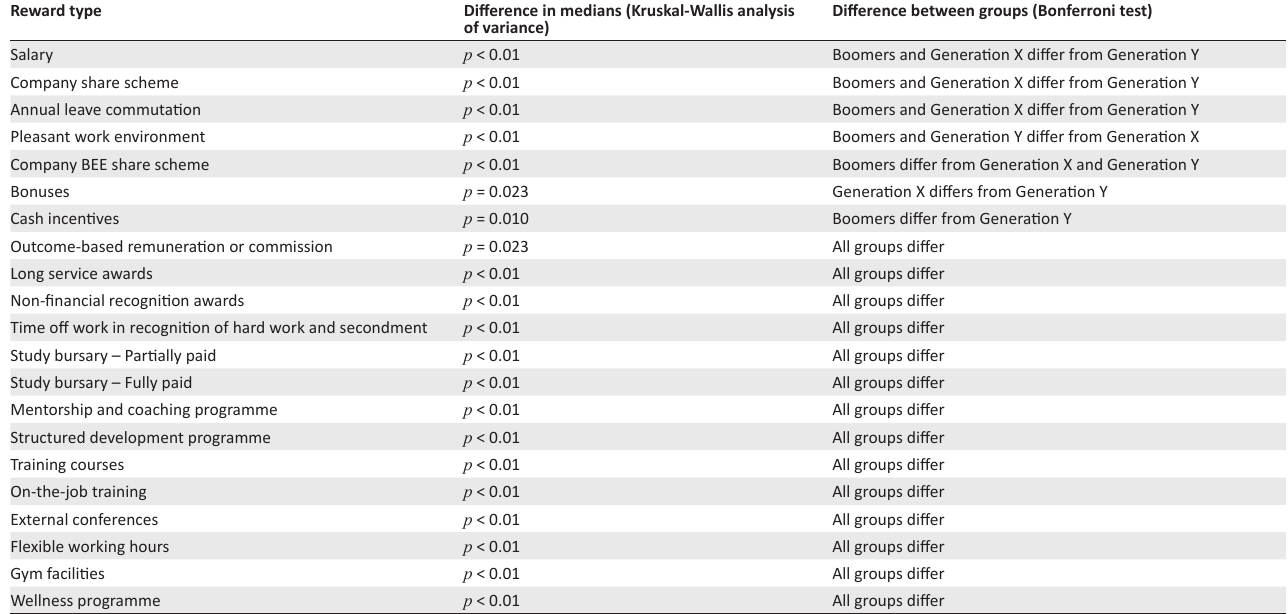
TABLE 5: Preferences in rewards amongst respondants. Reward